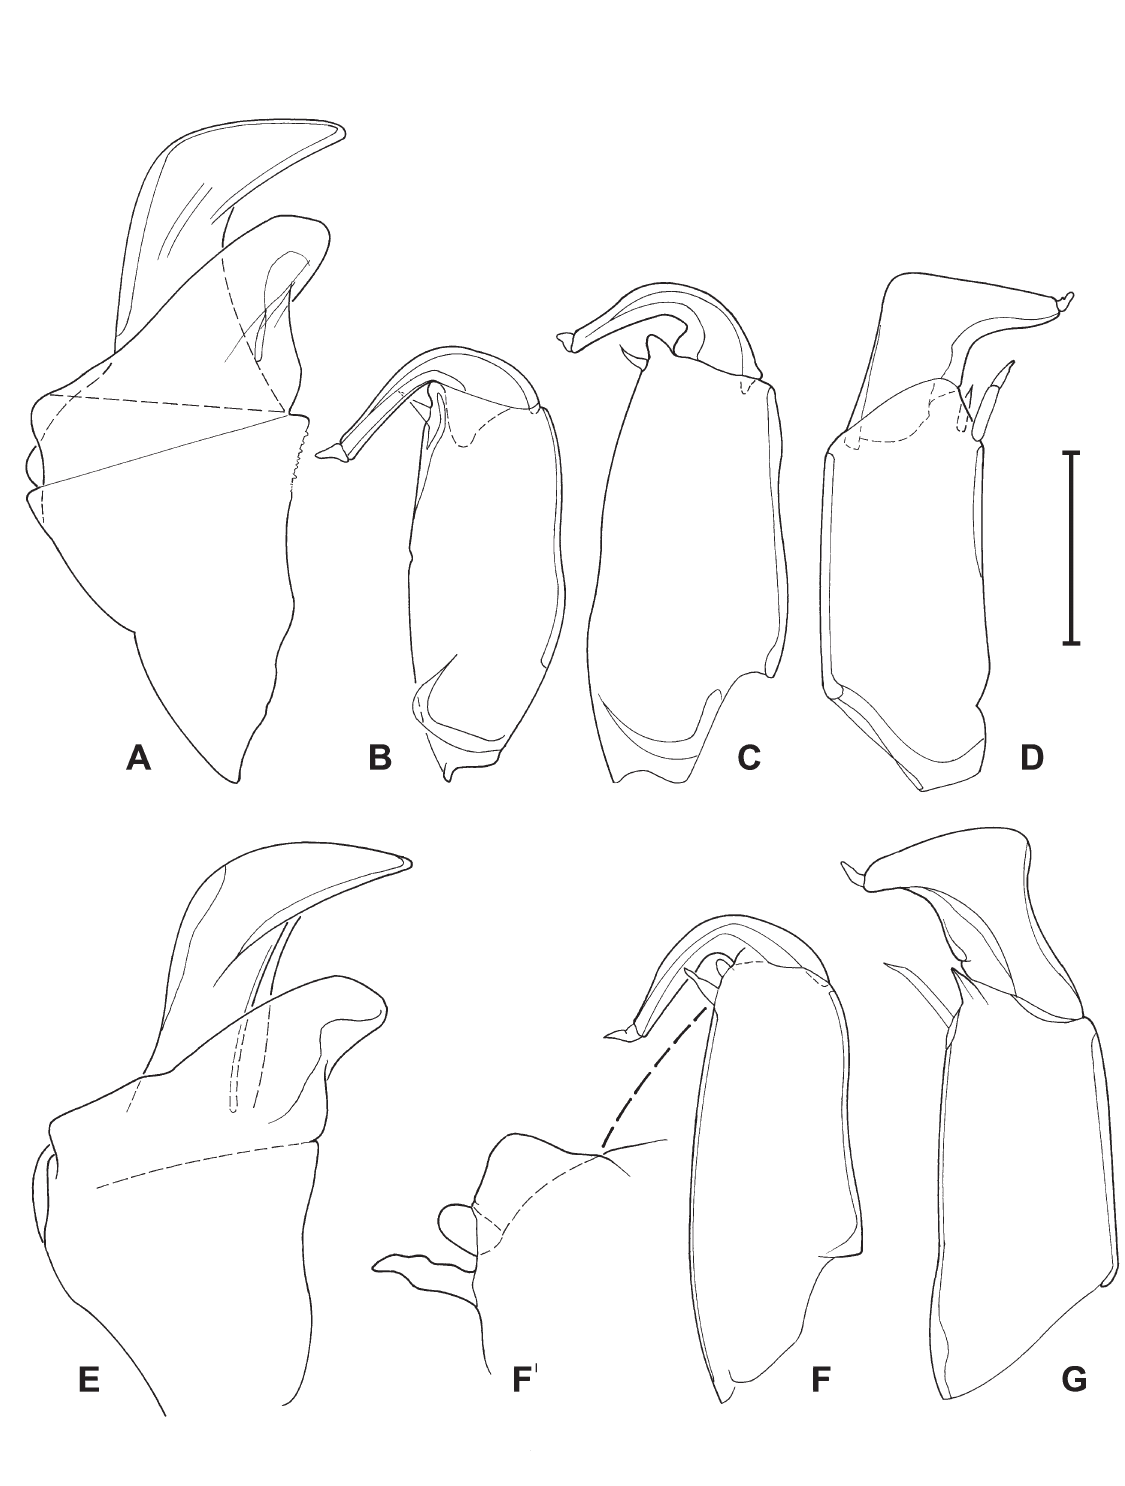
Fig. 13. Bennelongia triangulata sp. nov. (all ♂, A–D from CB75a, Cattle Camp Pan, Gascoyne, WA; E–G holotype (WAMC55564): cane grass pan on Wooramel Station, Murchison/Gascoyne, WA). A . Outline of hemipenis (WAMC55584). B . Lpp (WAMC55584). C . Lpp (WAMC55575). D . rpp (WAMC55584). E . Outline of hemipenis. F . lpp. F’ . Lpp, detail of distal part of first segment. G . rpp. Scale = 156 µm for A, E; 73 µm for B–D,